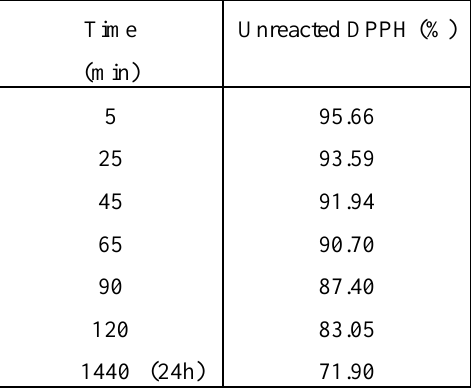
Table 1. Kinetics of unreacted DPPH ( 1a ) in the reaction with 18C6 and KO